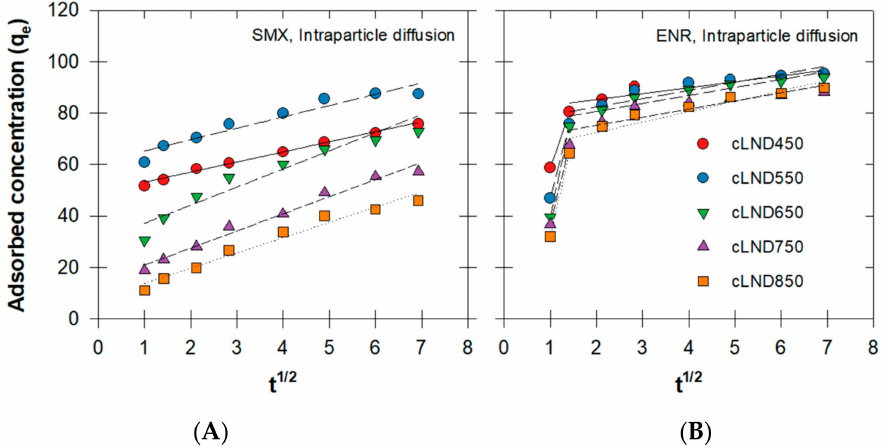
Figure 6. Effect of ( A ) initial pH and ( B ) humic acid concentrations on SMX or ENR removal efficiency using cLND550.